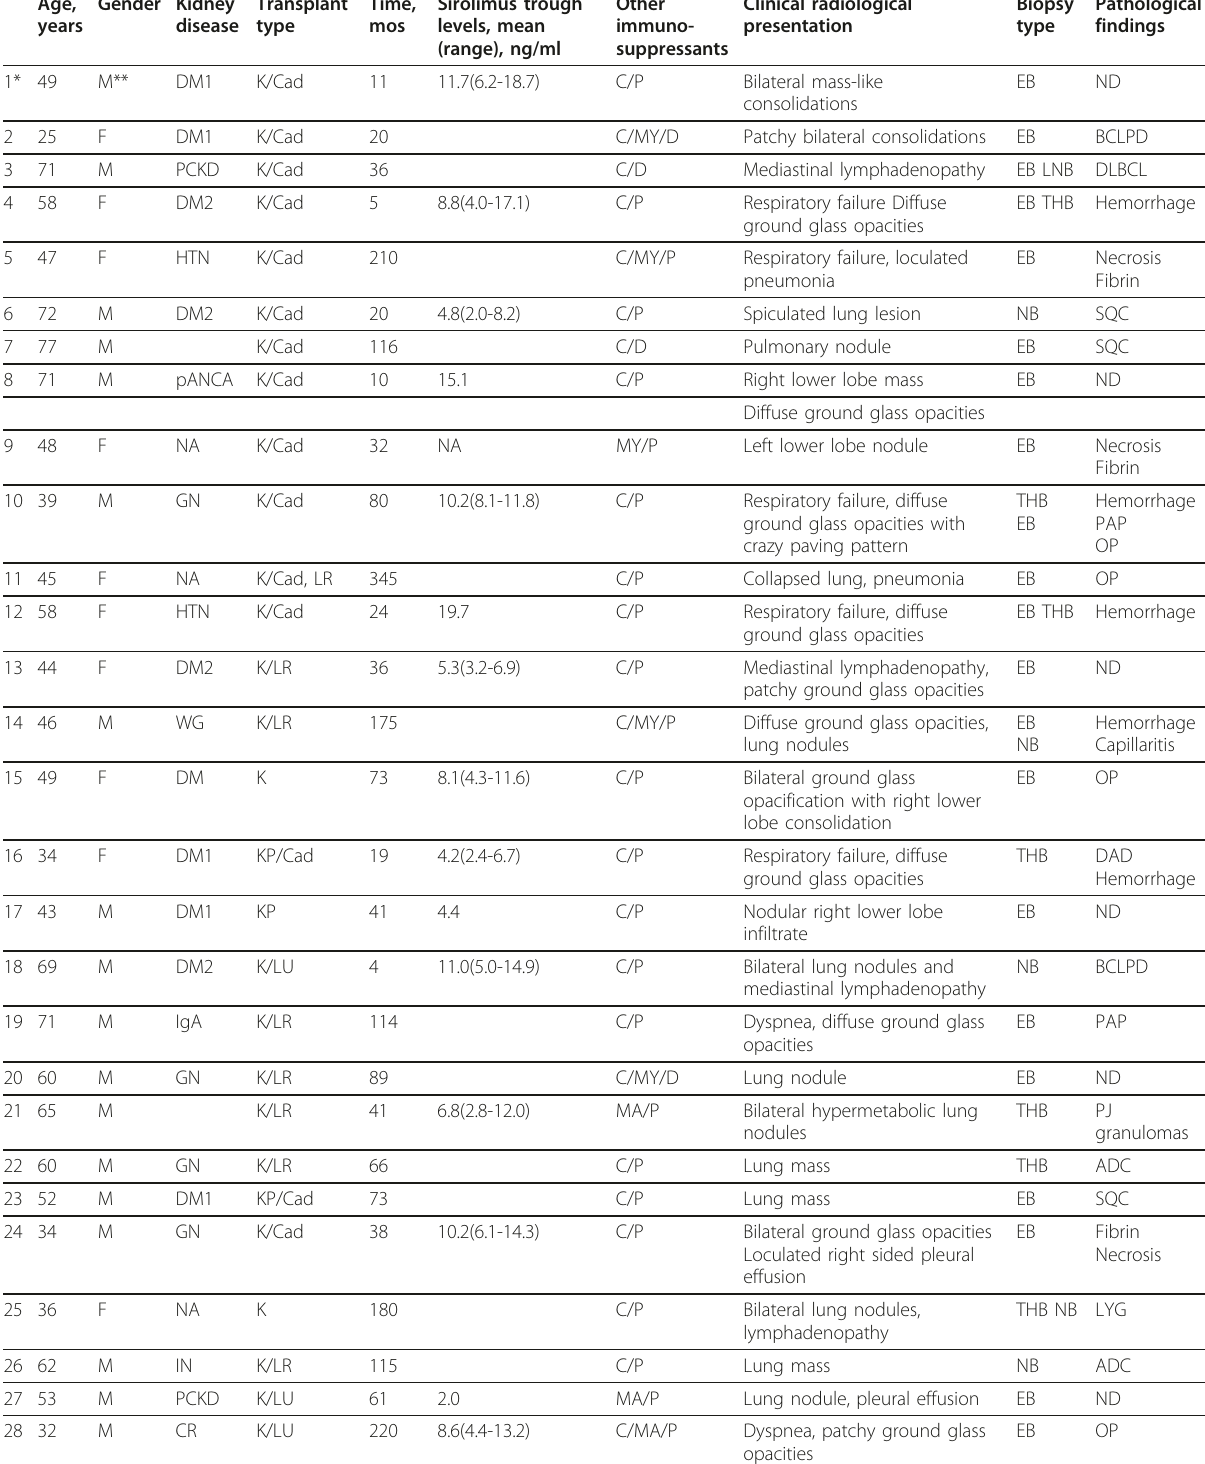
Table 1 Clinical pathological findings in kidney transplant recipients Age, Gender Kidney Transplant years disease